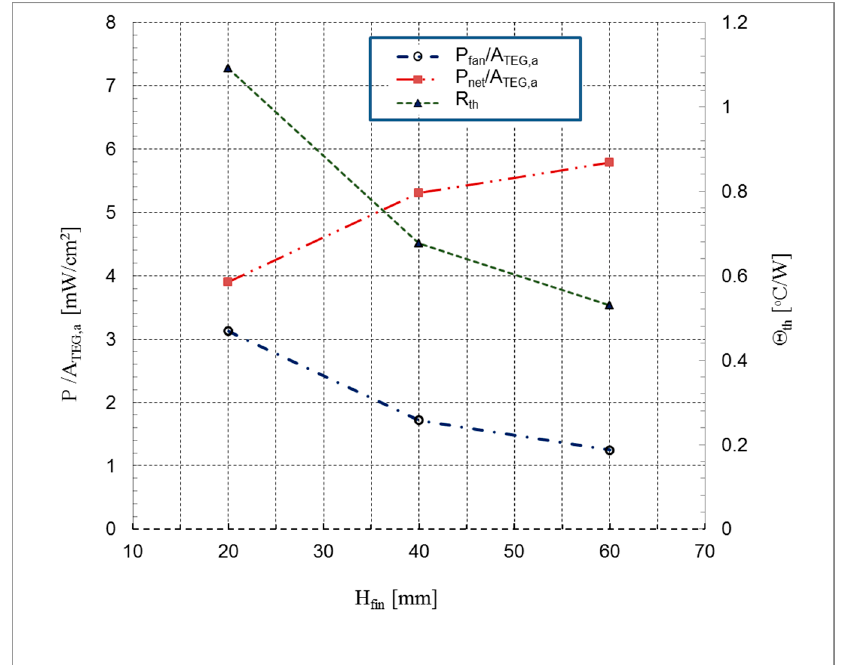
Figure 13. Variation of P / A TEG,a (P fan / A TEG,a or P net / A TEG,a ) and total thermal resistance ( Θ th = R th ) as a function of fin height (H fin ).